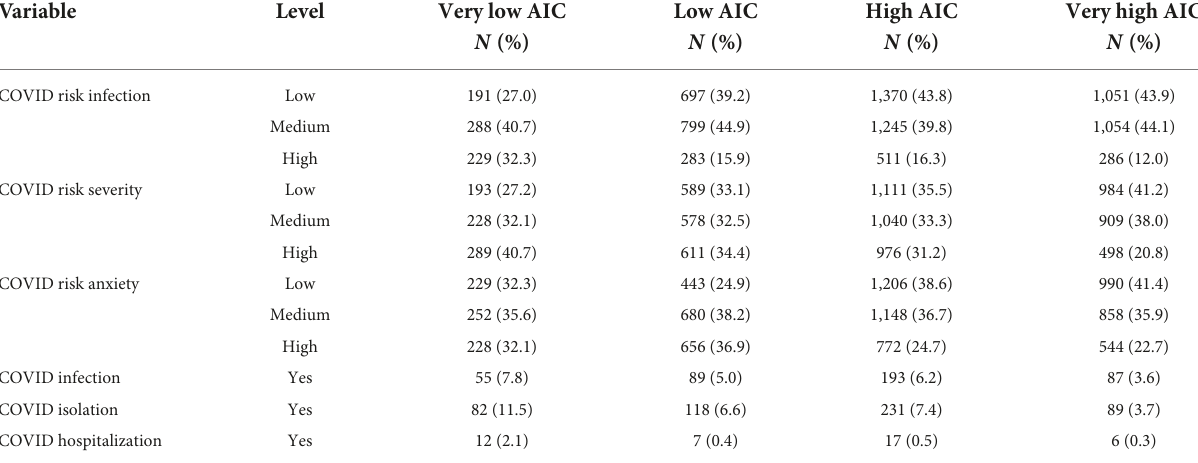
TABLE 2 COVID-19-related risk perceptions and impacts per the AIC group: weighted data analysis. Variable